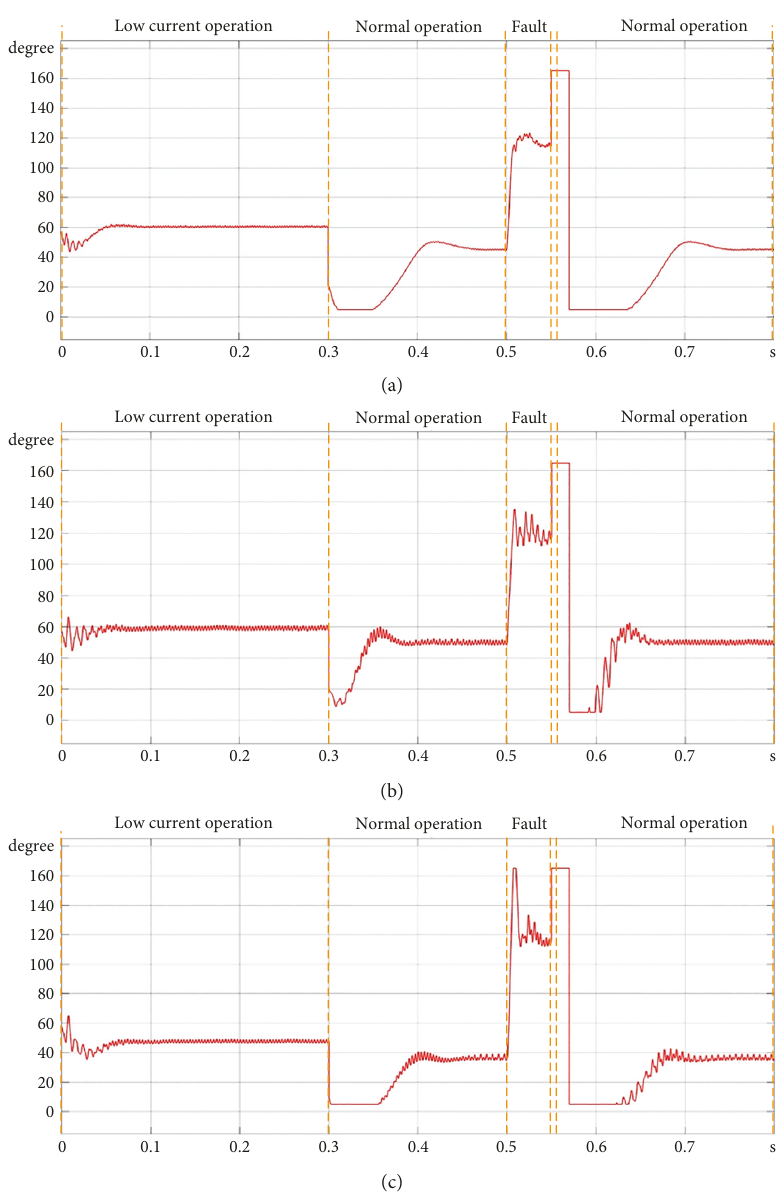
Figure 4: Alpha angle of the HVDC transmission line. (a) A 250kV HVDC transmission line (250 kV, 500kVA, 2kA), (b) a 450V HVDC transmission line (450 V, 750VA, 1.667A), and (c) a 500V HVDC transmission line (500V, 750 VA,